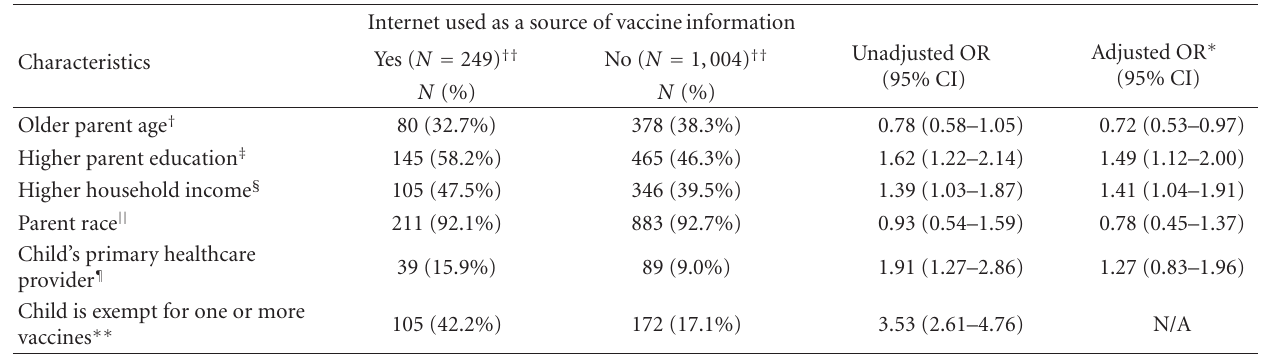
Table 2: Demographic characteristics as predictors for Internet use as a source of vaccine information among parents of school aged children.